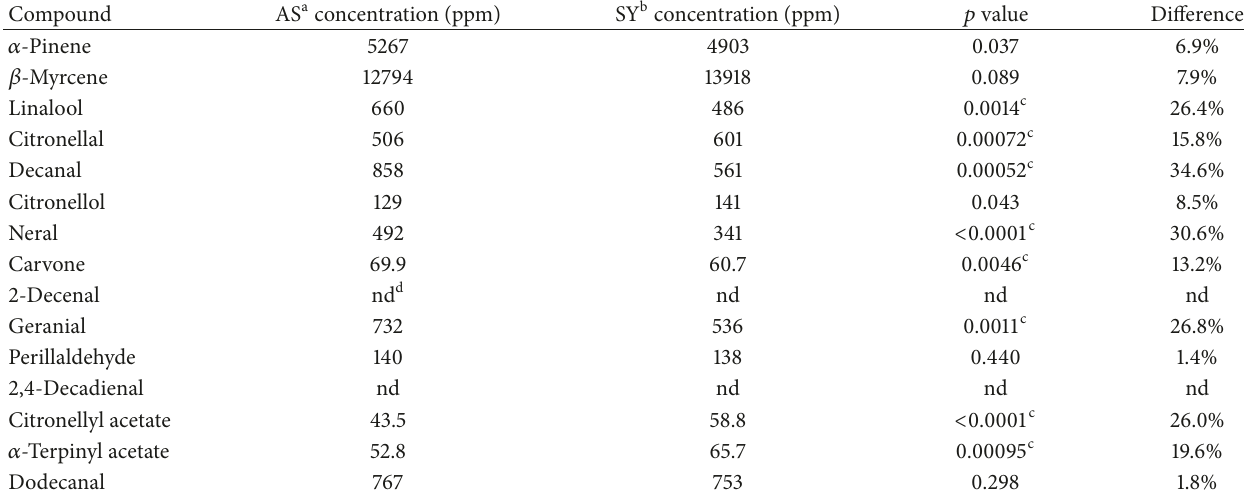
Table 3: Hamlin early asymptomatic versus symptomatic compound